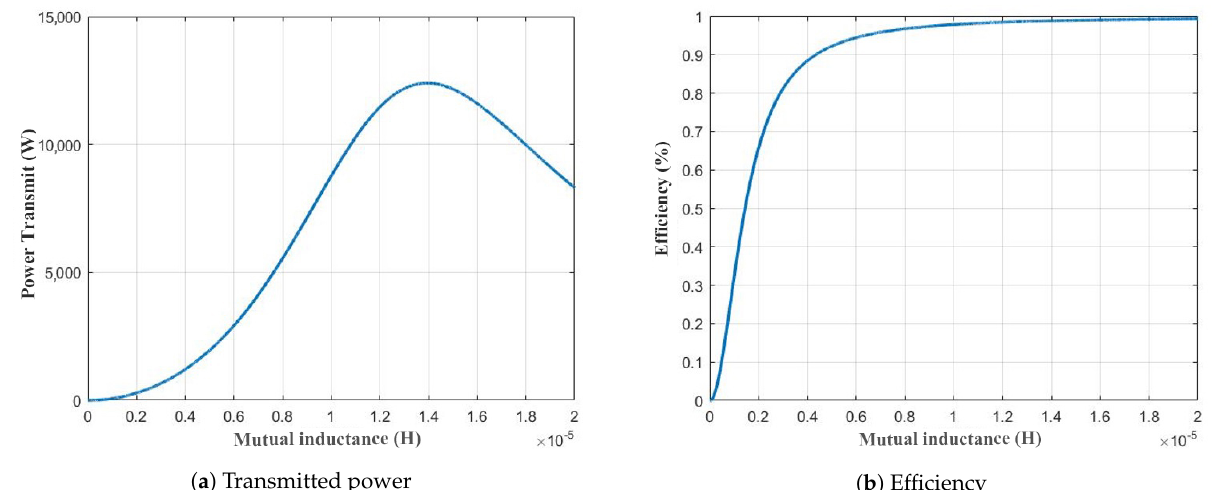
Figure 12. The affect of various mutual